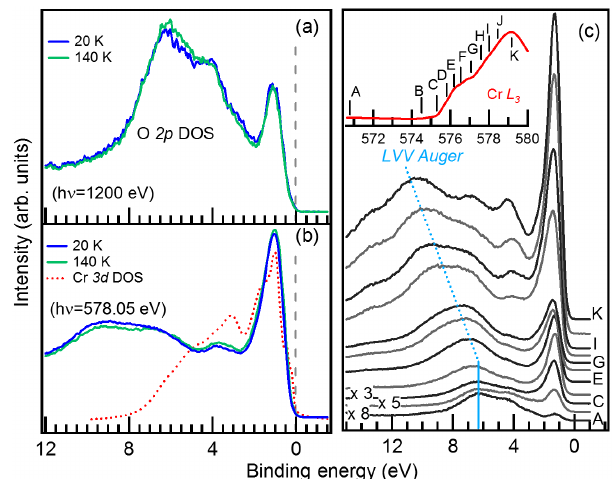
FIG. 2. Soft X-ray valence-band photoemission spectroscopy (PES) of K 2 Cr 8 O 16 . Valence band PES spectra of K 2 Cr 8 O 16 obtained using (a) h ν ¼ 1200 eV and (b) h ν ¼ 578 . 05 eV and compared with the calculated Cr 3 d partial DOS. (c) Resonant- PES measured across the Cr 2 p − 3 d threshold at 20 K using photon energies indicated by tick marks (A-K) on the Cr L 3 XAS curve shown in the